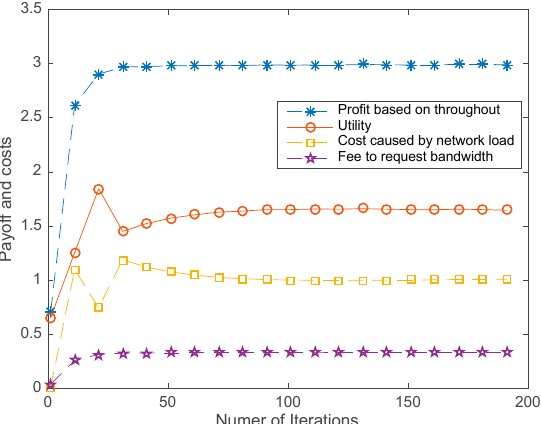
Figure 5. Payoff and costs of mobile user in area 2 with the number of iterations.